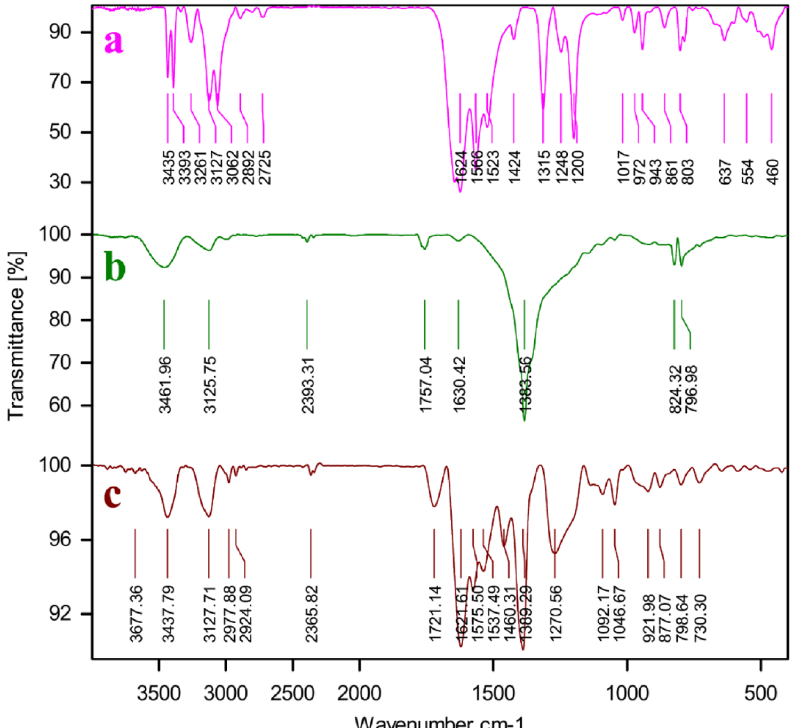
Figure 1. FT-IR Spectrums of ( a ) 4,6-diamino-2-pyrimidinethiol, ( b ) Siler nitrate and ( c )